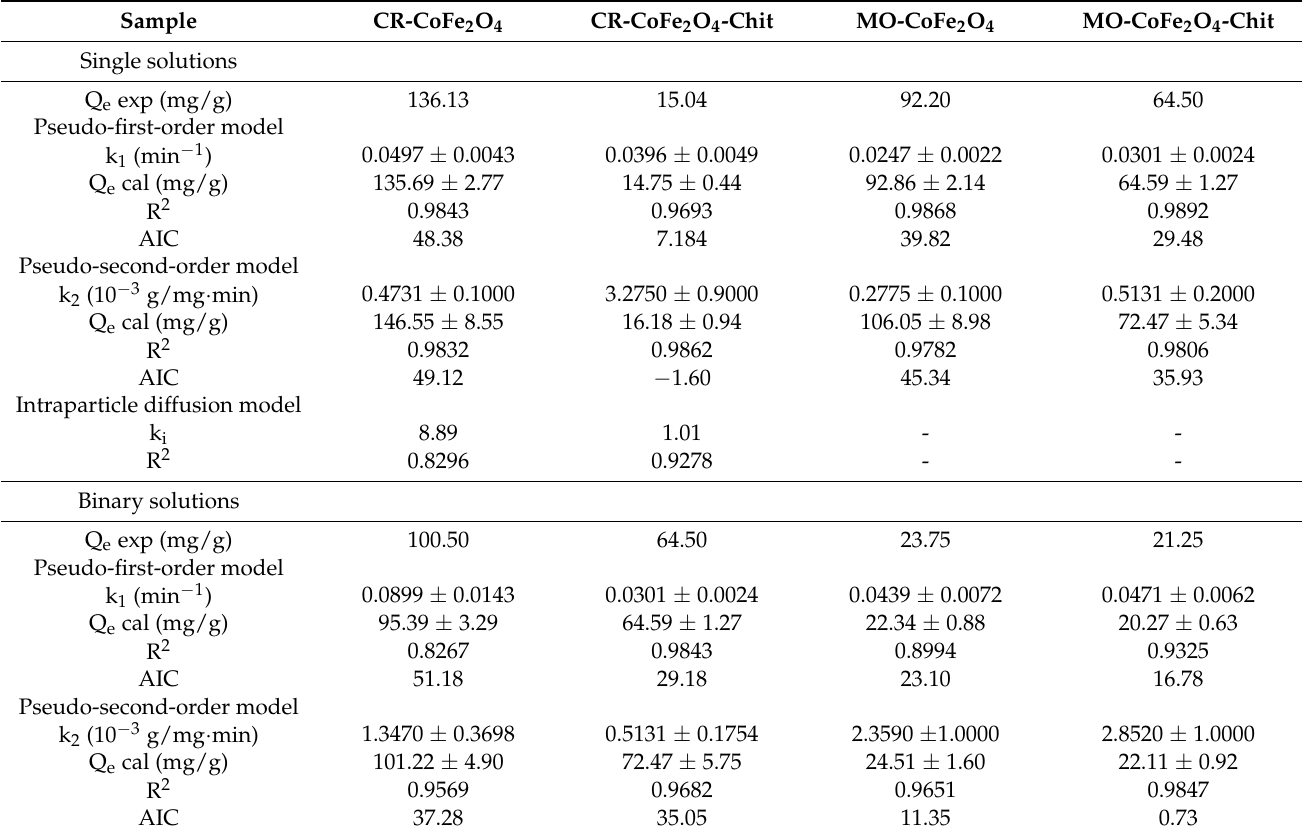
Table 4. The kinetic parameters for the dyes’ adsorption onto CoFe 2 O 4 and CoFe 2 O 4 –Chit obtained by nonlinear regression of the experimental